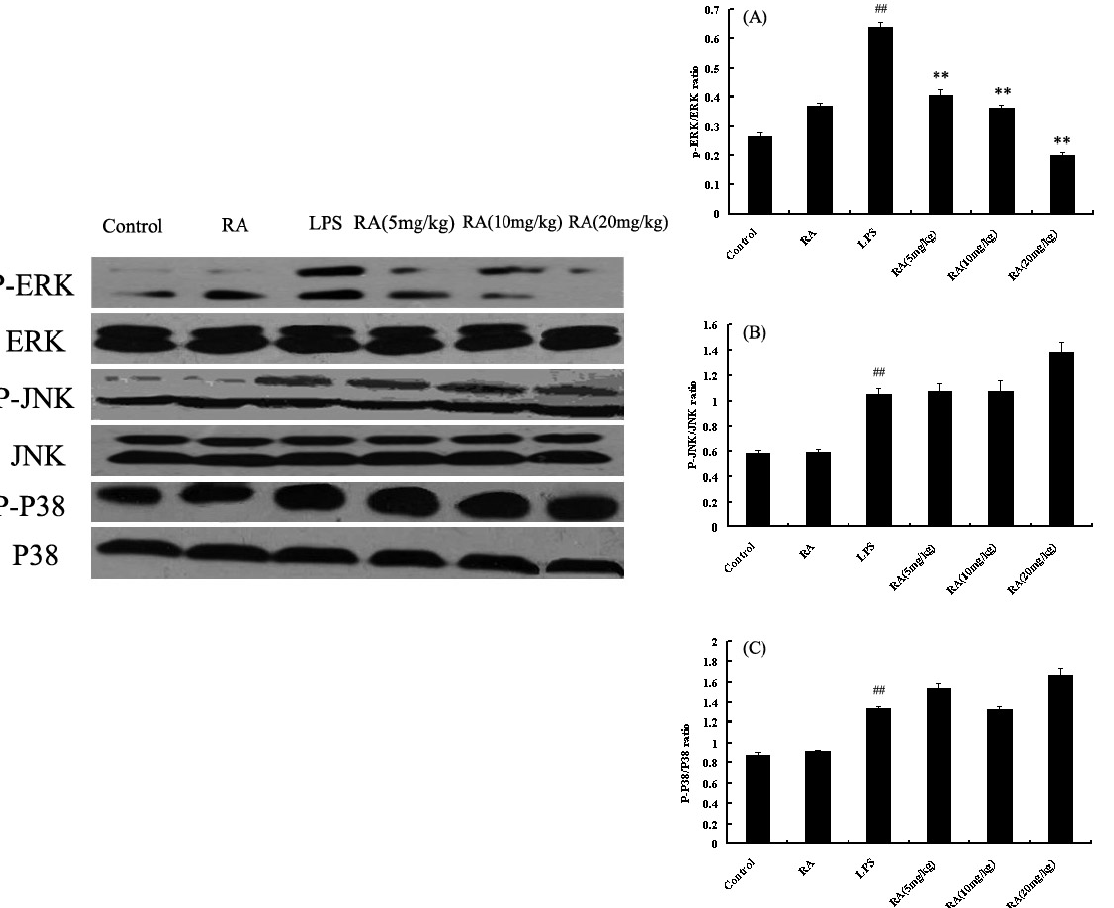
Figure 6. Effects of RA on MAPK activation in vivo . Total cellular proteins from lung were analyzed by Western blot with specific antibodies. Experiments were repeated three times and similar results were